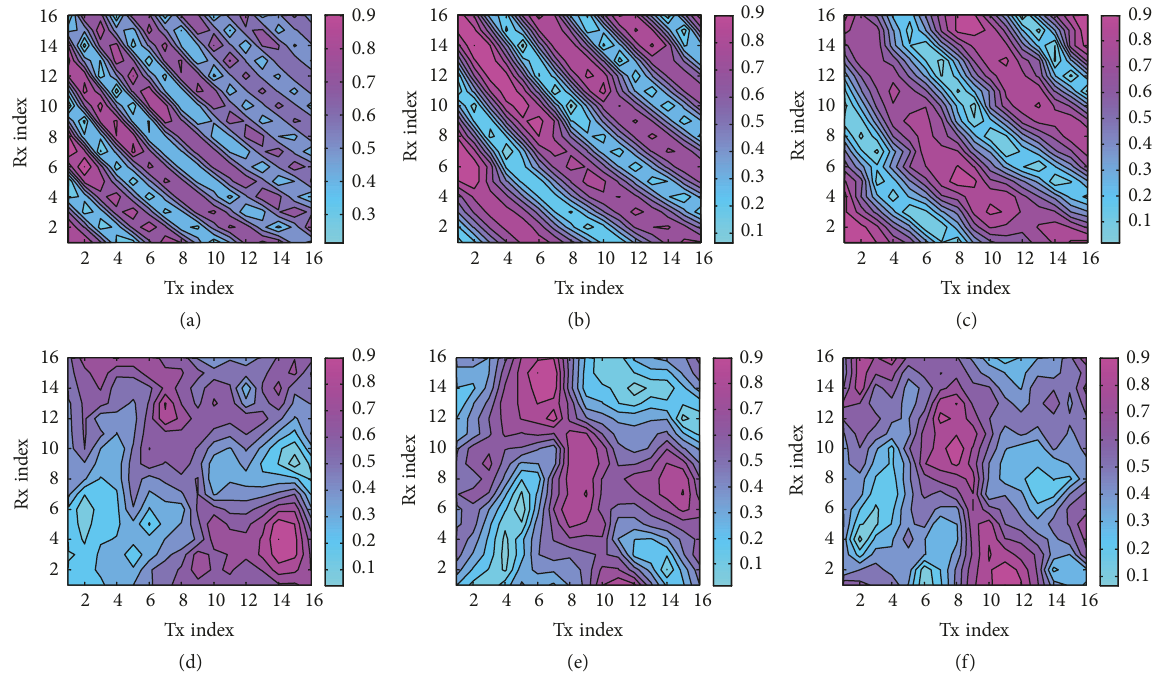
Figure 15: Simulated (ray tracing) amplitude matrices at (a) 15m, (b) 25 m, (c) 35 m, (d) 65 m, (e) 75 m, and (f) 85